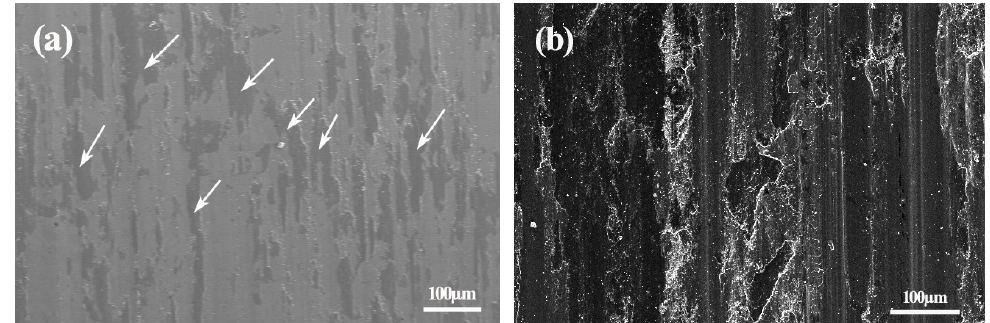
Figure 5. SEM micrographs showing the worn surface morphologies of ( a ) the Ni–Mo–Si ternary intermetallic composite and ( b ) hardened 0.45% C steel wheel counterpart under room temperature dry-sliding wear conditions.